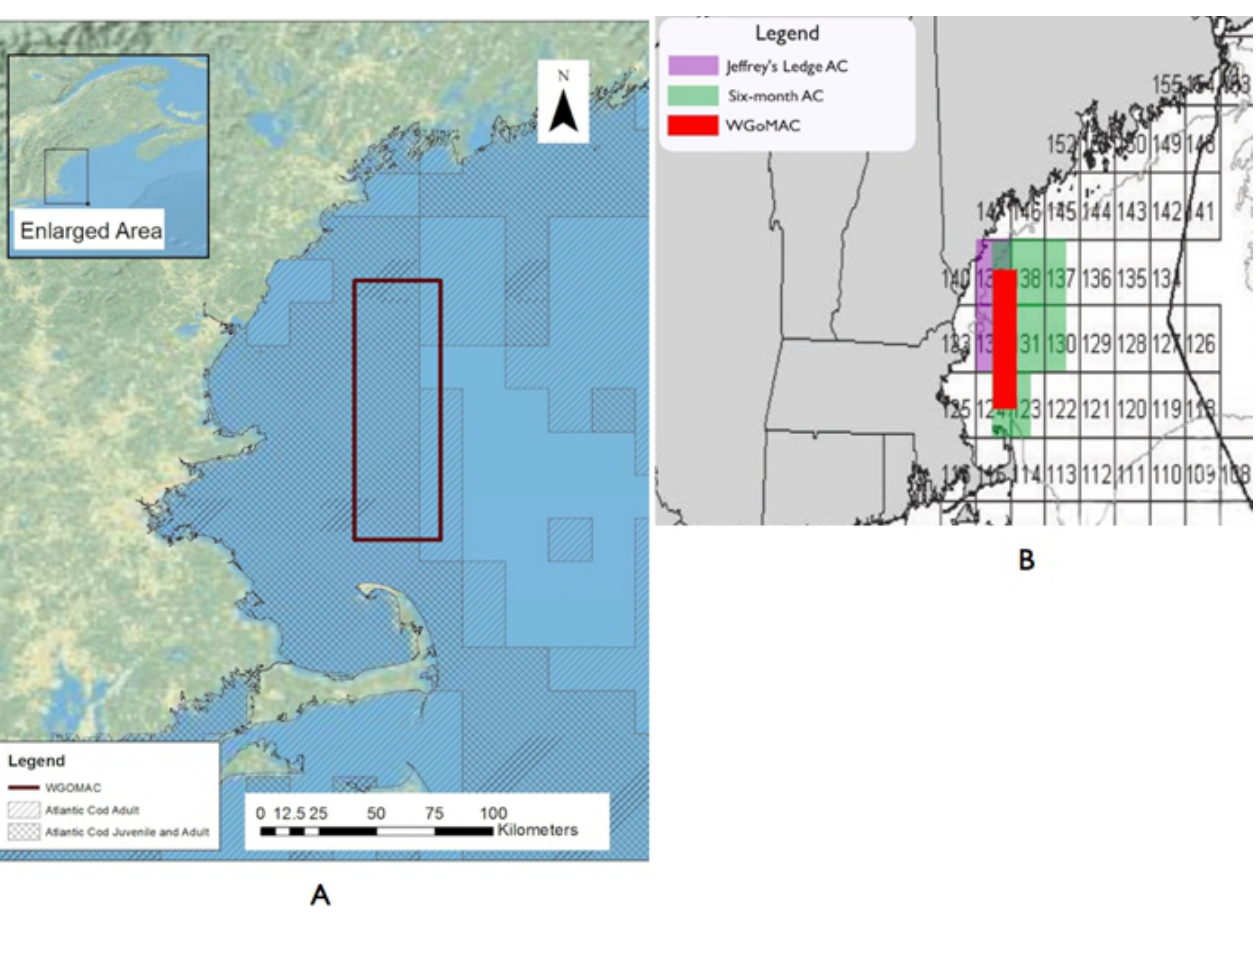
Figure 1A). The regulation created a year-round closure and prohibited any commercial vessel with gear capable